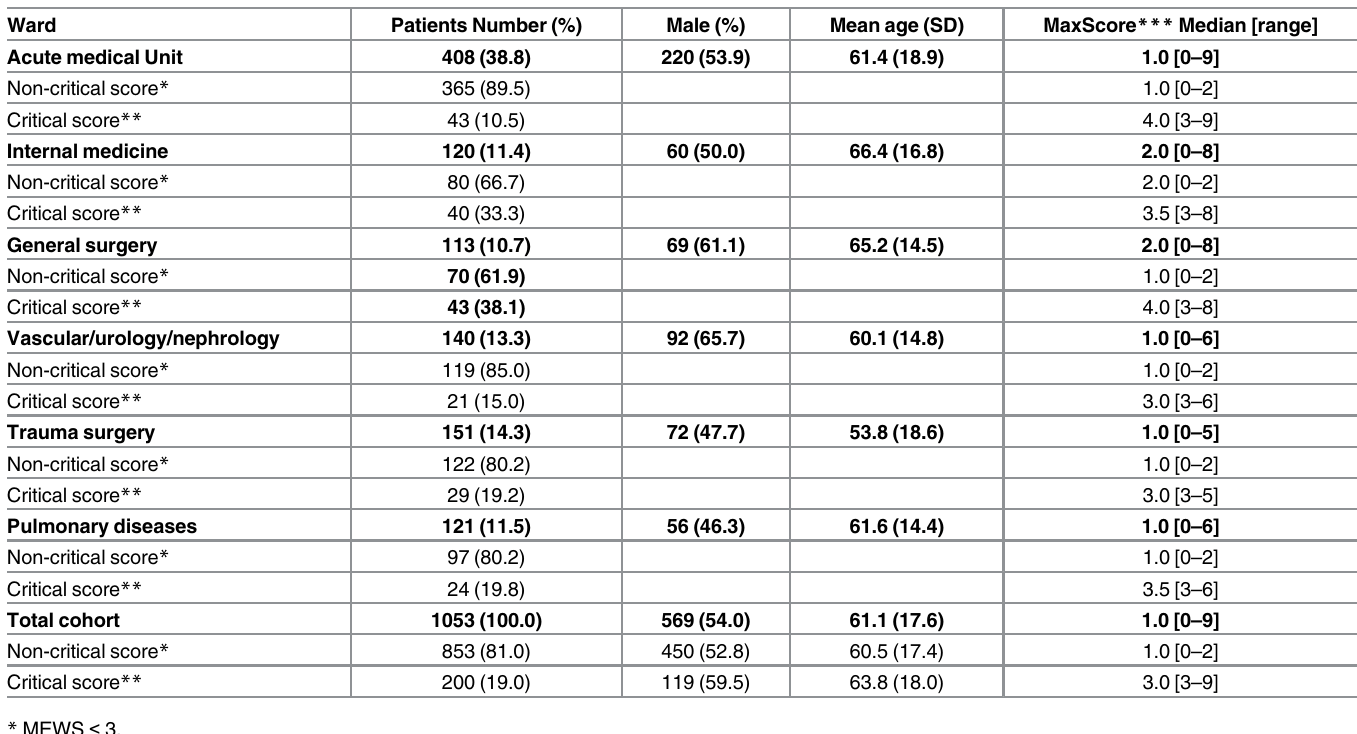
Table 1. Patient characteristics (N =